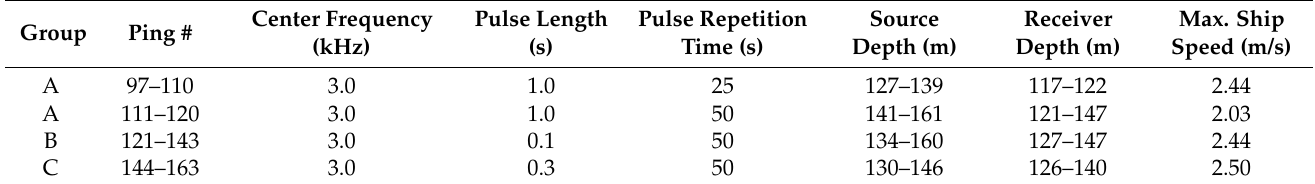
Figure 2. Bathymetry map and trajectory of R/V Cheonghae during the 3 kHz CW measurements. Arrows indicate array direction at each position of the towing ship and are drawn for every fourth ping. The dashed line indicates the broadside of the array at ping 97 and its length is 1 km. Table 1. Pulse parameters and operation conditions of source/receiver.